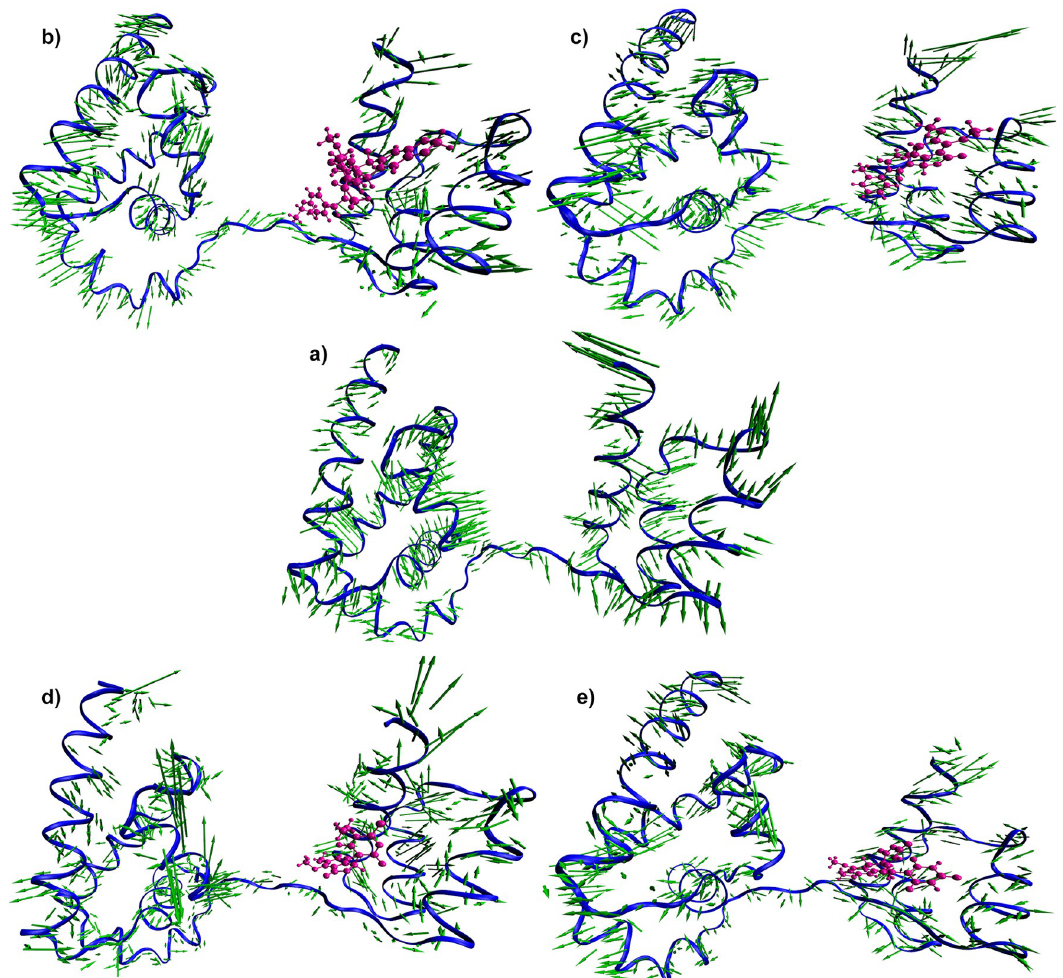
Fig 11. Mode vector analysis. Porcupine plots depicting the dominant motions exhibited by the backbone atom of apoprotein (a) and the compounds NPB7083 (b) , ZINC20410920 (c) , ZINC02145000 (d) , and ZINC32124203 (e) bound proteins. The arrows attached to each backbone atom indicate the direction of movement of protein and the length of each arrow shows the magnitude of the